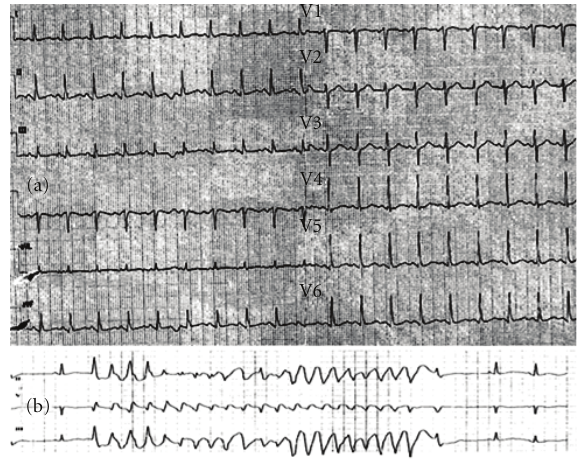
Figure 1: (a) Baseline ECG: sinus tachycardia (119bpm), QTc 441ms. (b) self-terminated episode of TdP.